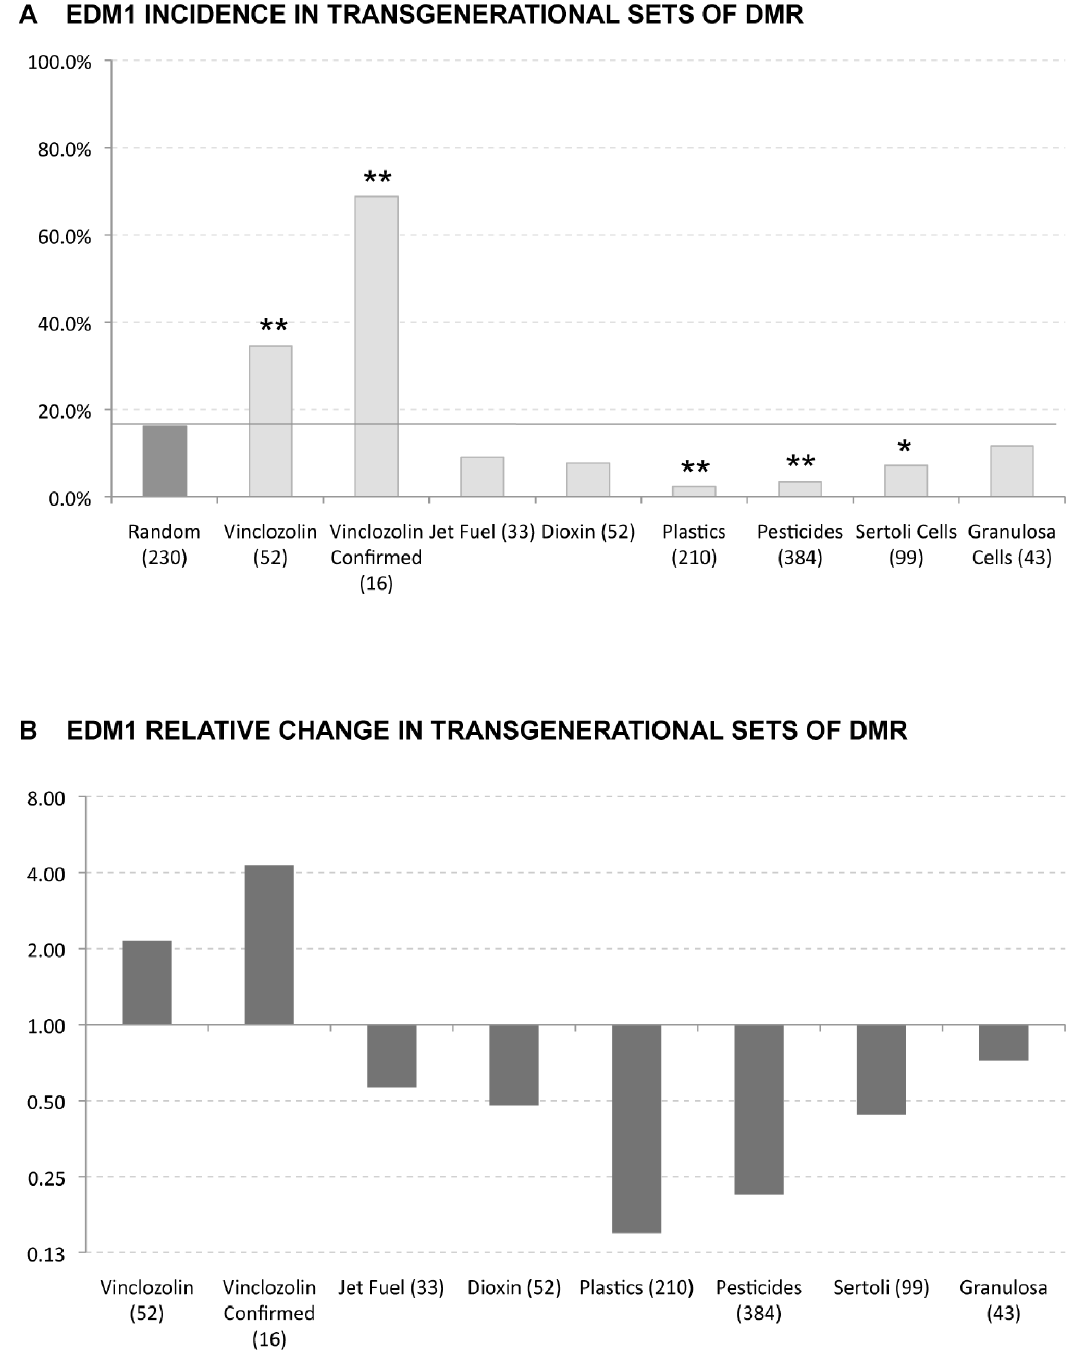
Figure 2. EDM1 incidence in exposure specific epimutation data sets. (A) Individual occurrence (percentage) of EDM1 in a variety of sets with transgenerational DMR and (B) relative change of EDM1 in these DMR. Columns with ** represent significant change with p , 0.01, while columns with * represent significant change with p , 0.05.